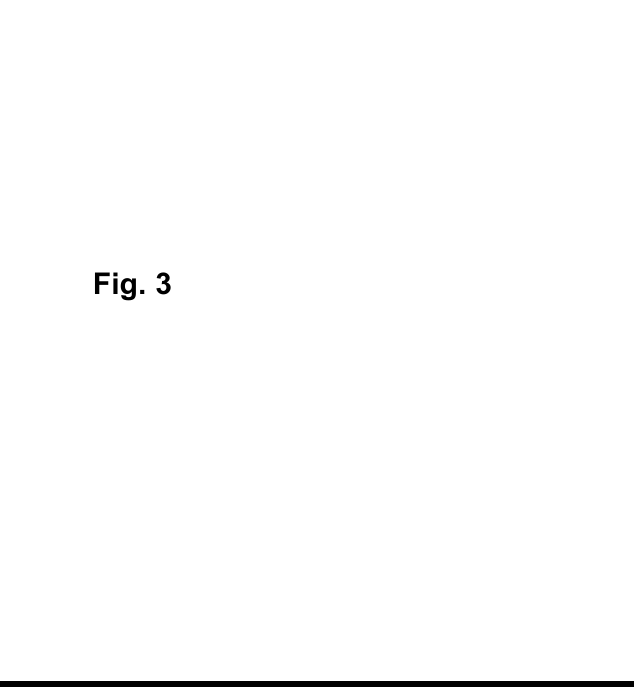
Fig.3 : Direct sequencing result of the protein C gene promoter region fragment encompassing the three polymorphic